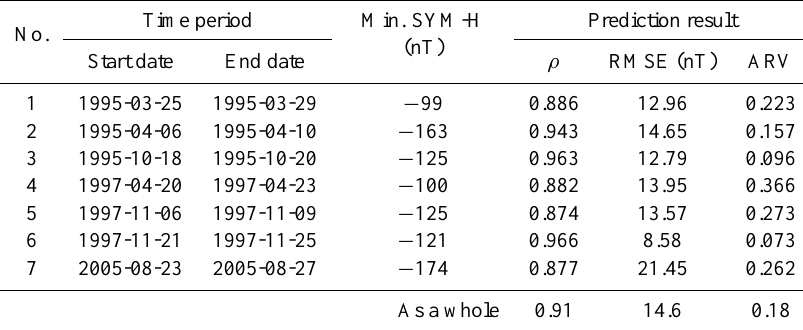
Fig. 6. Comparison of observed SYM-H index with that predicted by NARX neural network with output-feedback delay time length of 120 min for testing storm events using ACE data. Table 3. Prediction result of each test event whose IMF/SW data are from